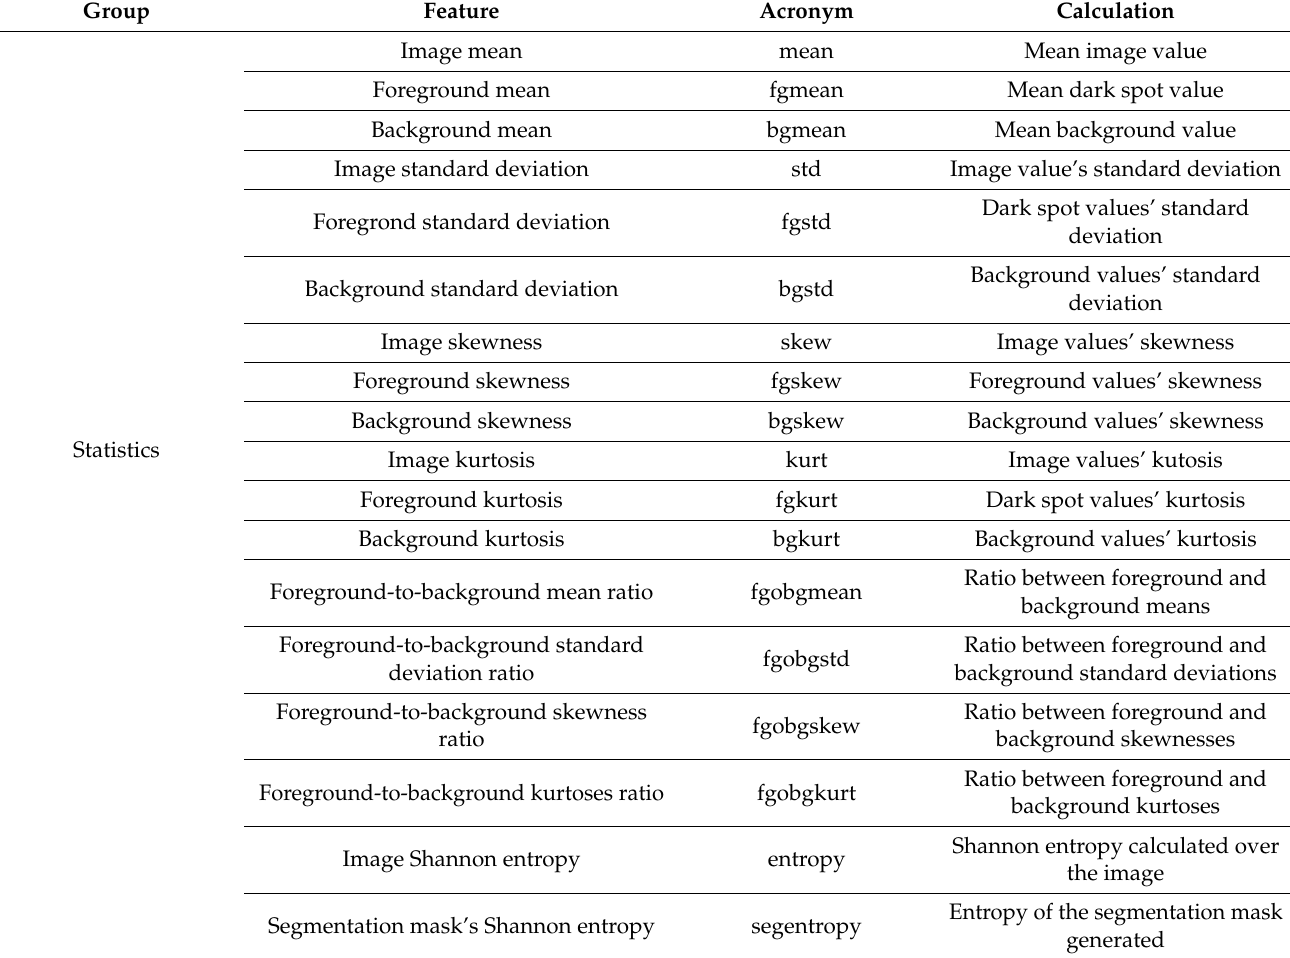
Table 1. Features used grouped in five main categories, along with their acronyms and calculation description. Group Feature